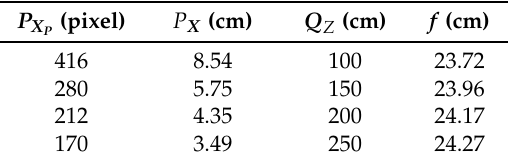
Table 1. Results of focal length f measurement ( Q X = 36 cm).